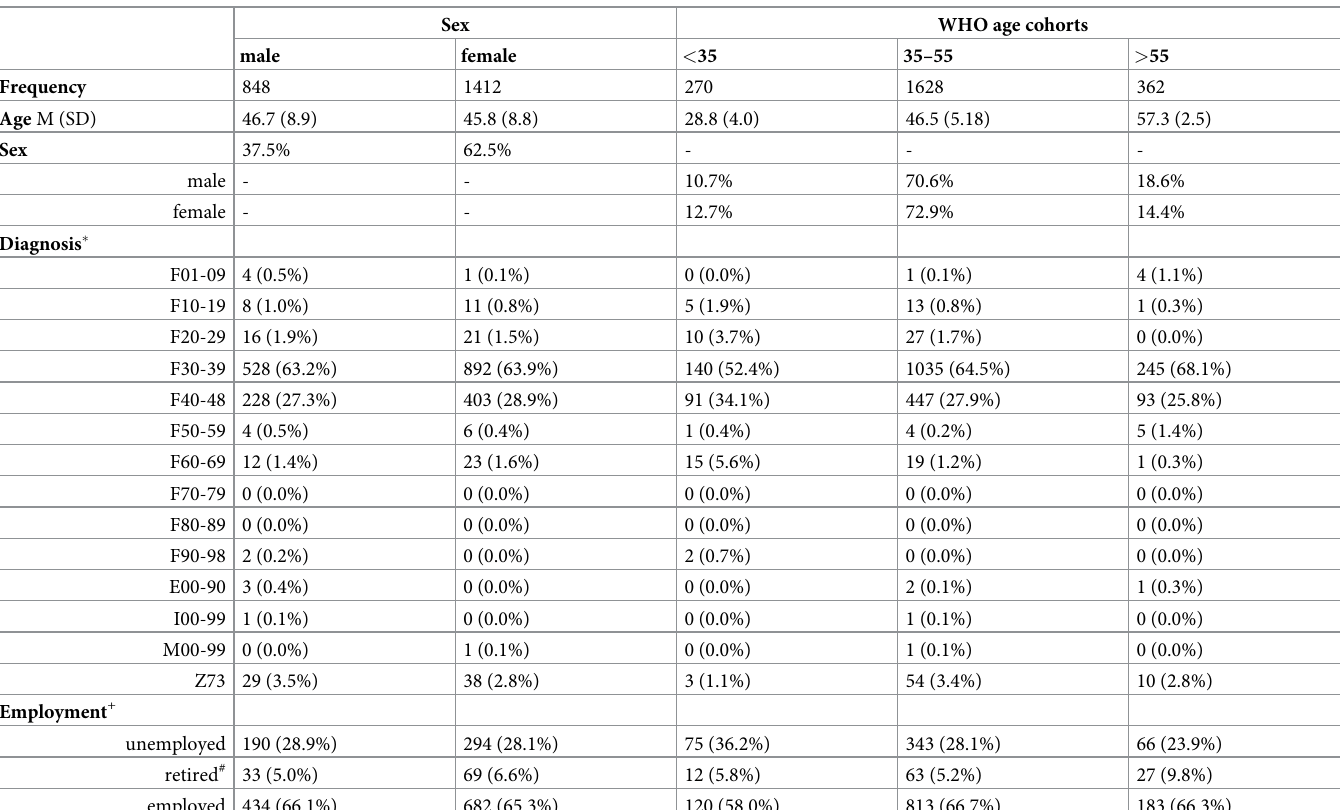
Table 1. Sample characteristics by age cohort and